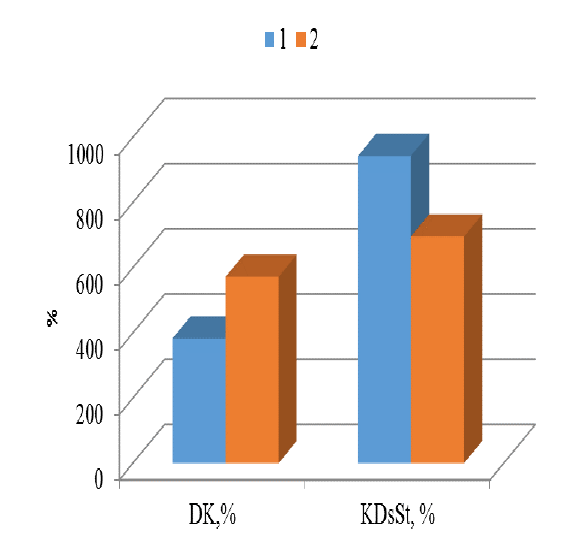
Fig.1. Indicators of induced lipids’ peroxidation (DC – diene conjugates; KDsCt – keto-diene and coupled trienes in both groups (group 1 (1), group 2 (2), %